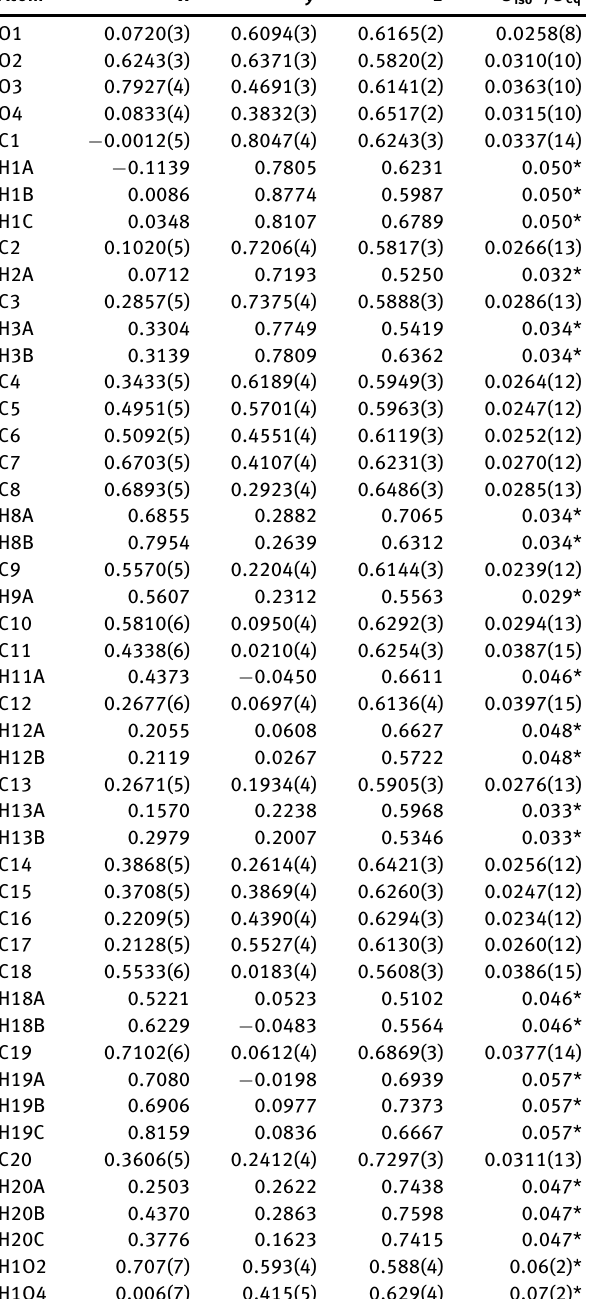
Table 2: Fractional atomic coordinates and isotropic or equivalent isotropic displacement parameters (Å 2